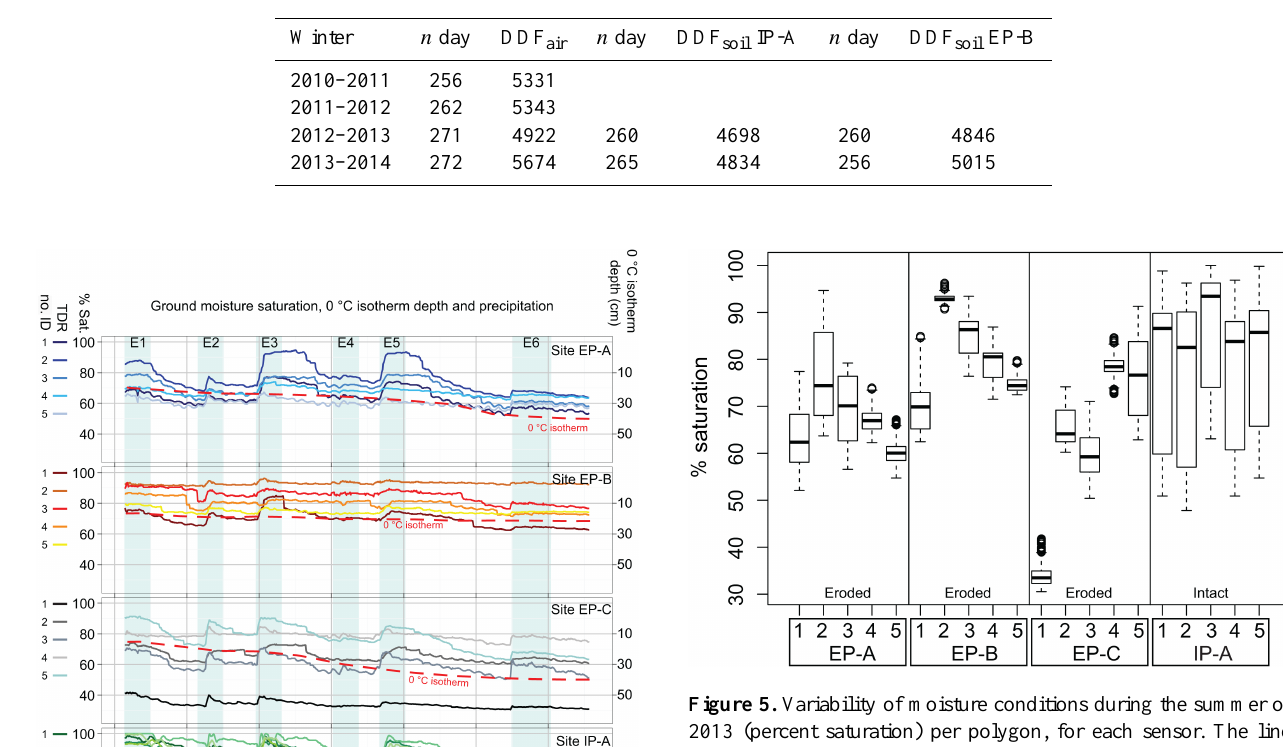
Table 2. Degree days of freezing (DDF air ) as recorded by the on-site meteorological stations, between 2010 and 2014 (CEN, 2014), and DDF soil for EP-B and IP-A (the winter of 2012–2013 and 2013–2014). The length of the thawing season is indicated for each measured unit under its respective n day column.